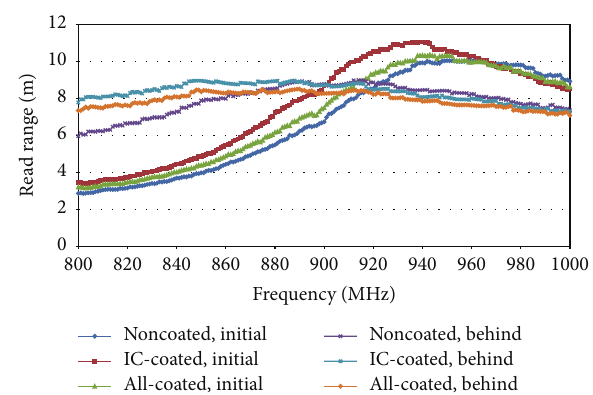
Figure 6: Measurement results behind 4 cm thick wooden wall.